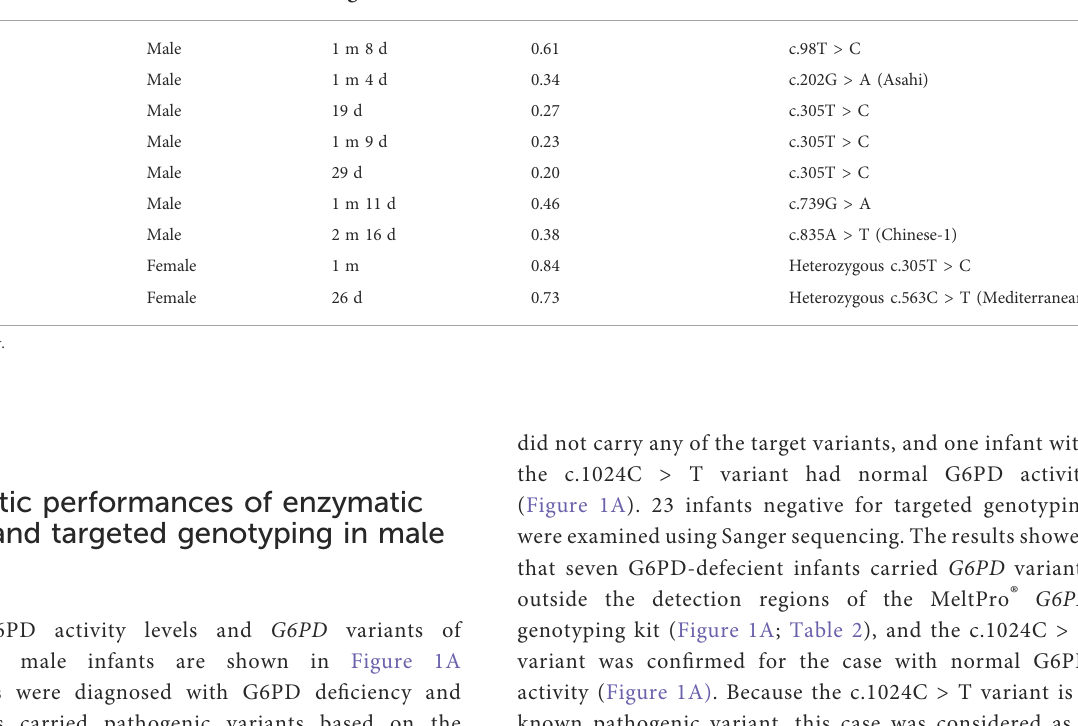
TABLE 2 Sanger sequencing results of G6PD de fi cient cases who were negative for targeted genotyping. Case